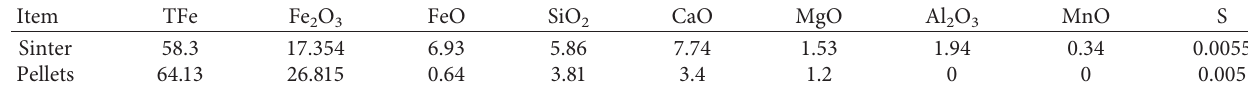
Table 2: Main chemical composition of raw materials.